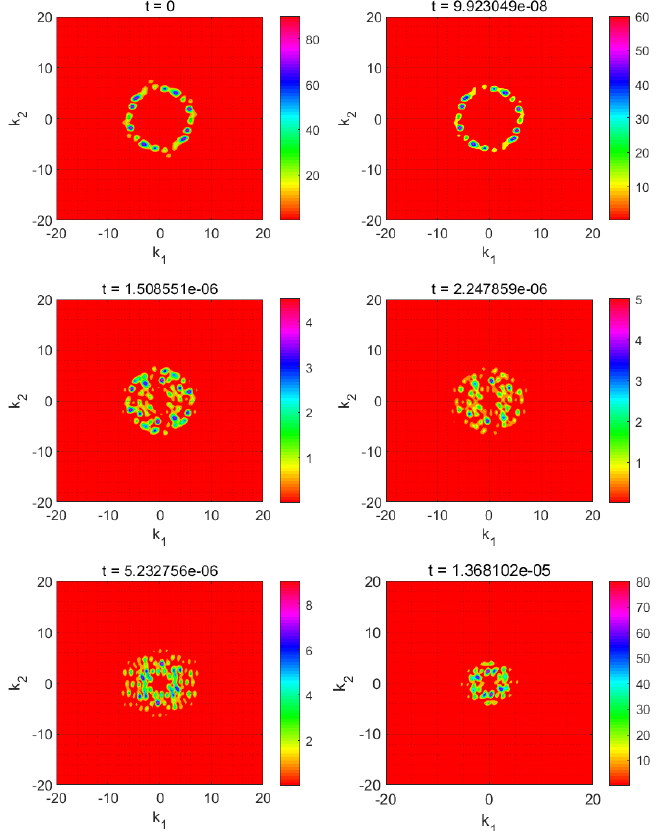
Figure 10. Simulated light scattering patterns obtained from the calculated structure factors for the case where D = 10 5 , c o* = 0.3 and T * = 035. The asterisks were left out of the variables k 1 , k 2 , and t in the figure.